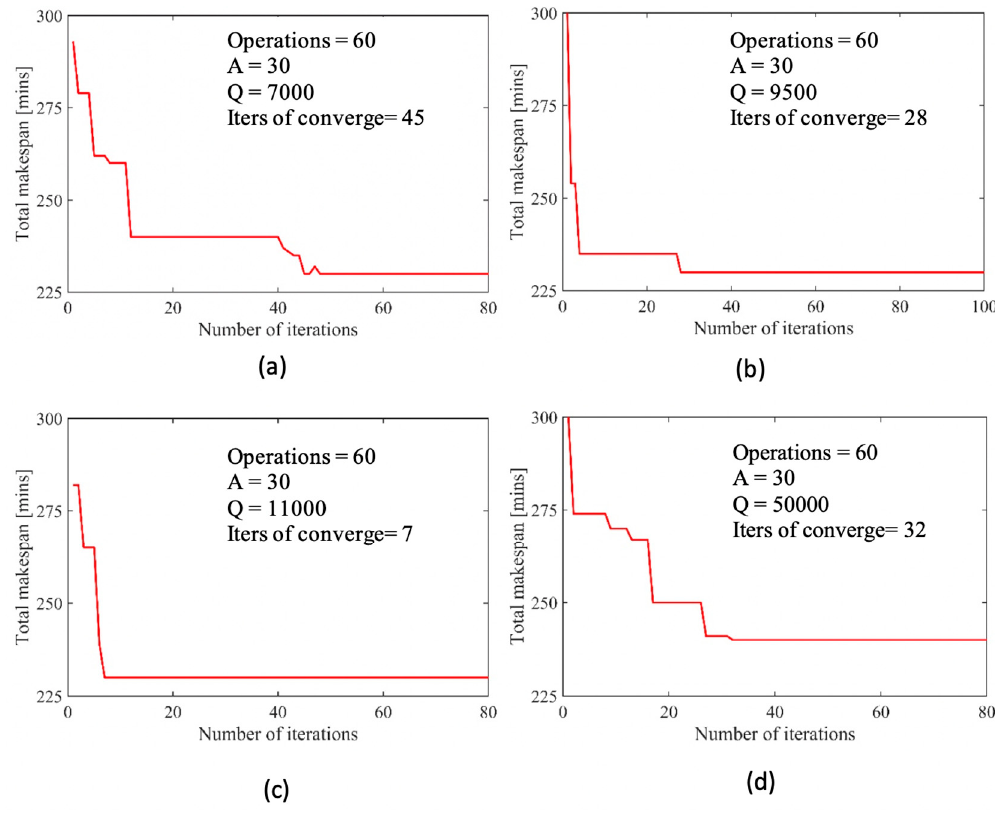
Figure 7. Tuning parameter Q for a use-case of 60 operations and fixed value of parameter A = 30: ( a ) Q = 7000, ( b ) Q = 9500, ( c ) Q = 11,000 and ( d ) Q = 50,000